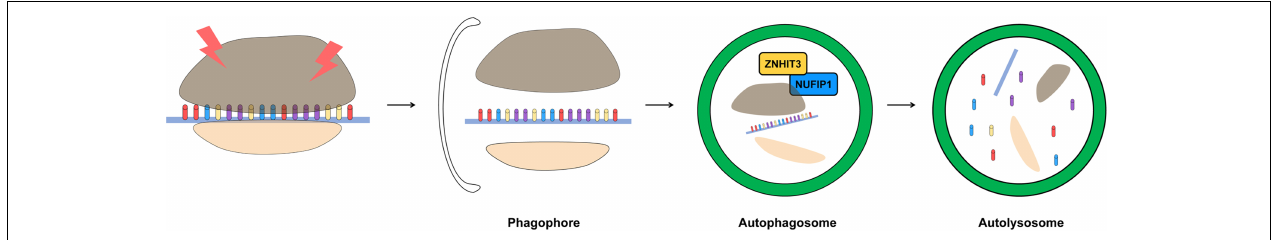
FIGURE 3 | Schematic representation of removing damaged ribosome by ribophagy. The accumulation of damaged ribosome is removed by ribophagy. For the most part, the ribosome is related to RNA but ribosome biogenesis is affected by DNA. DNA damage interrupts ribosome biogenesis and decreases the stability of rDNA. ZNHIT3 and NUFIP1 have been suggested as a major factors of ribophagy induction in mammalian